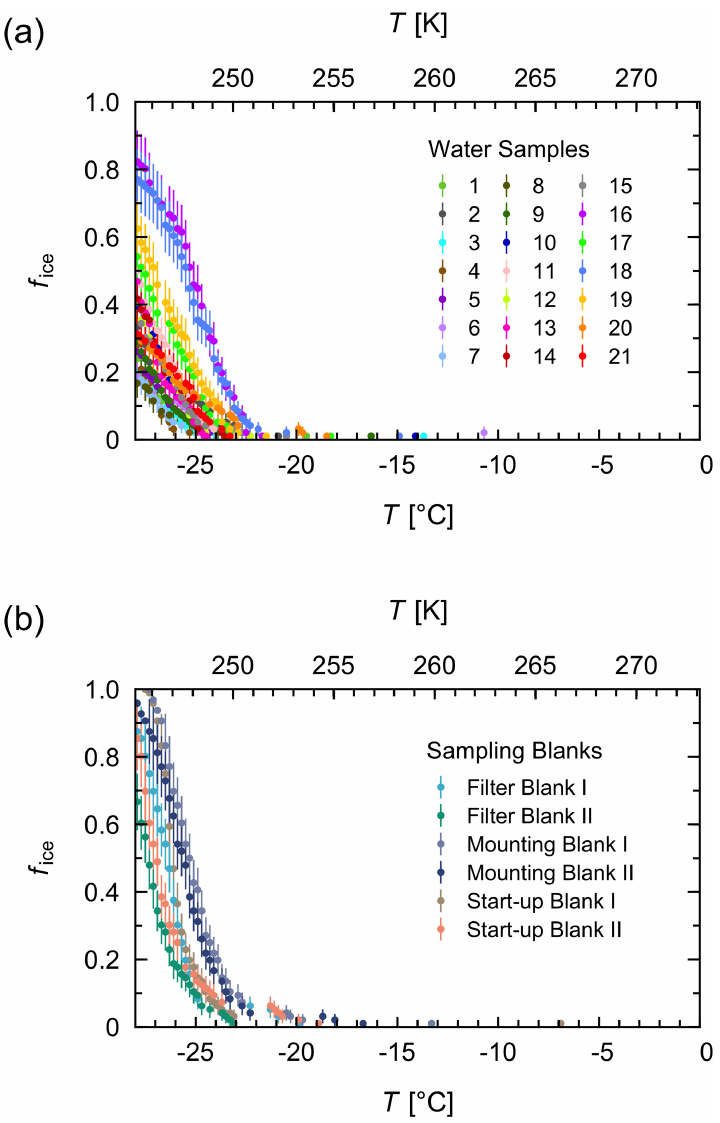
Figure B1. Negative controls of the freezing experiments. Fraction of frozen droplets ( f ice ) vs. temperature ( T ) for all water samples (a) and different types of sampling blanks that served as negative controls (b) . For each type of sampling blank, two filter pieces were measured. The error bars were calculated using the counting error and the Gaussian error